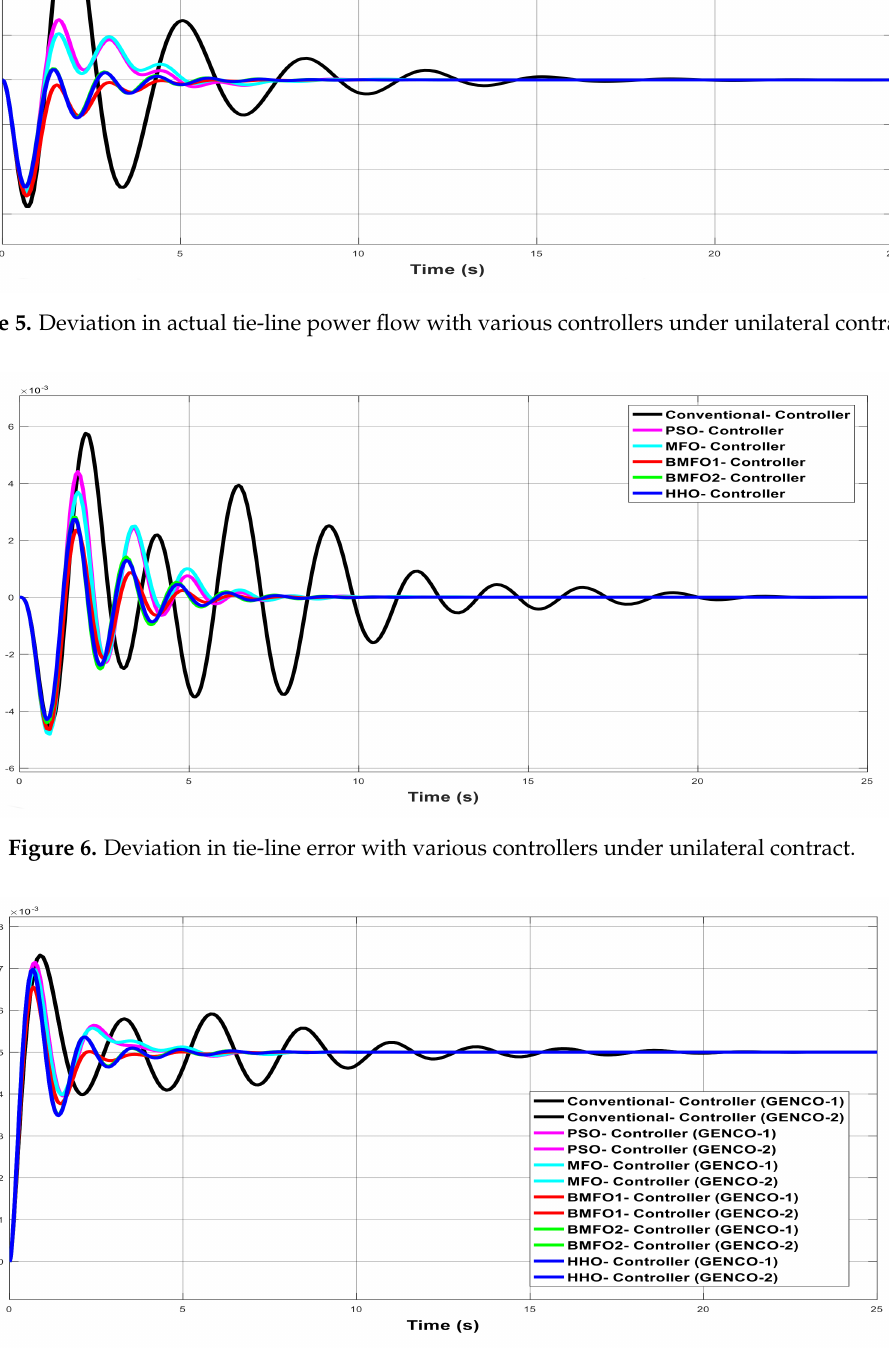
Figure 7. Generation Companies (GENCOs) generation response of Area1 with various controllers under unilateral